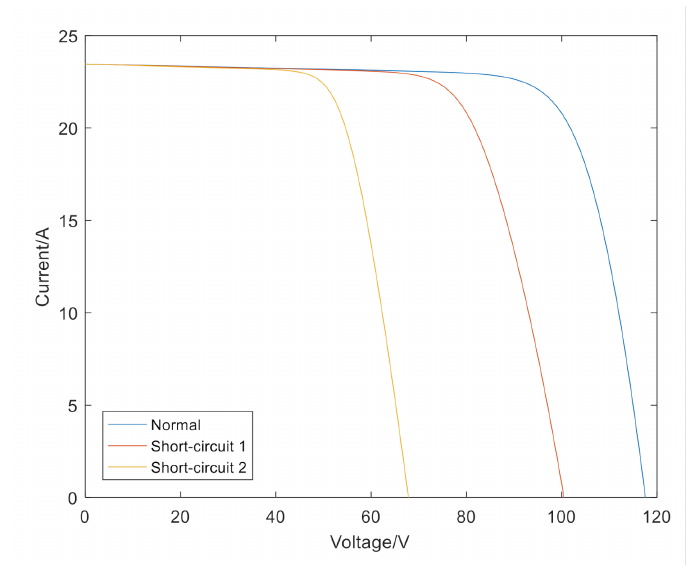
Figure 4. I-V curves of the PV array in case of the short-circuit faults. Partial shading: The partial shading fault may be caused by uneven solar radiation on the module. If some components are severely shaded, it will cause them to be reverse biased and consume power as a resistive load. The shaded components will generate heat at this time, forming hot spots, which will seriously damage the solar